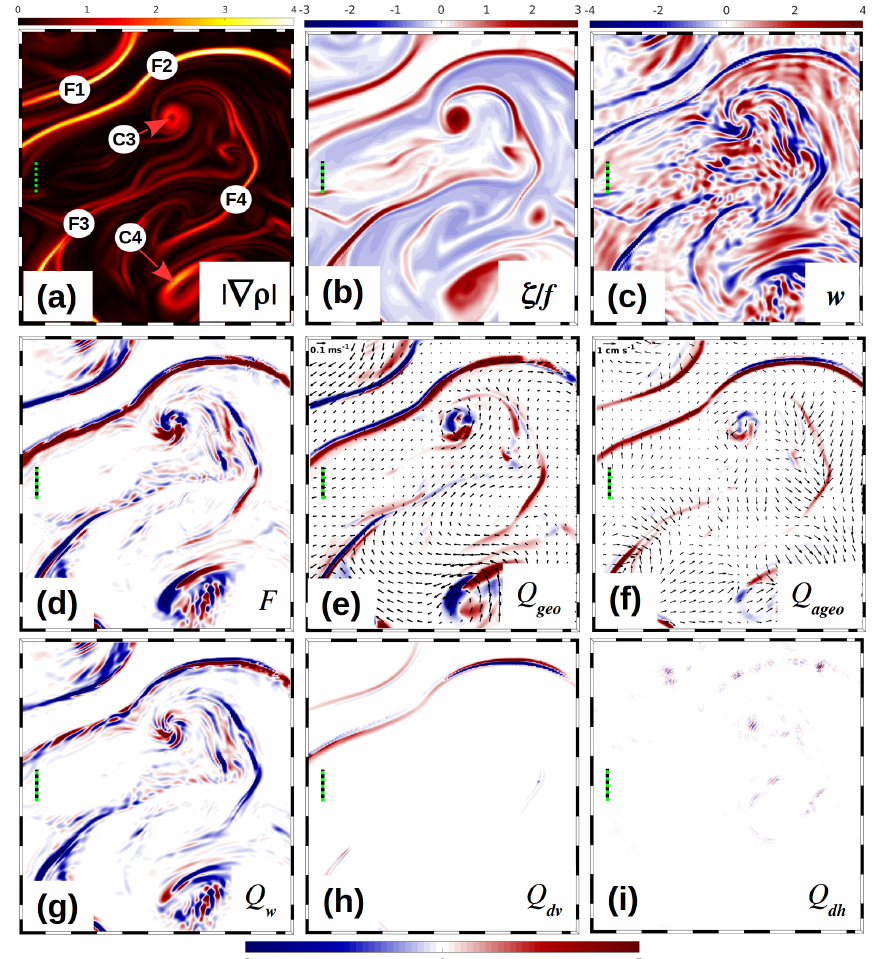
Figure 11. R100: near-surface properties on 26 June within the blue box depicted in Fig. 7a. (a) Absolute horizontal density gradient |∇ ρ | (10 − 4 kgm − 4 ) and (b) scaled relative vorticity ζ/f in the top layer, (c) vertical velocity w (md − 1 ) at the base of the top layer. (d) – (i) The frontal tendency F and the components of the tendency equation Q geo , Q ageo , Q w , Q dv , and Q dh (10 − 13 kg − 2 m − 8 s − 1 ) at 2m of depth. Red marks frontogenesis, and blue marks frontolysis. For the labels F1–F4, C3, and C4, see the text. The dashed rulers represent a distance of 2km; vectors in (e) and (f) are drawn at 600m